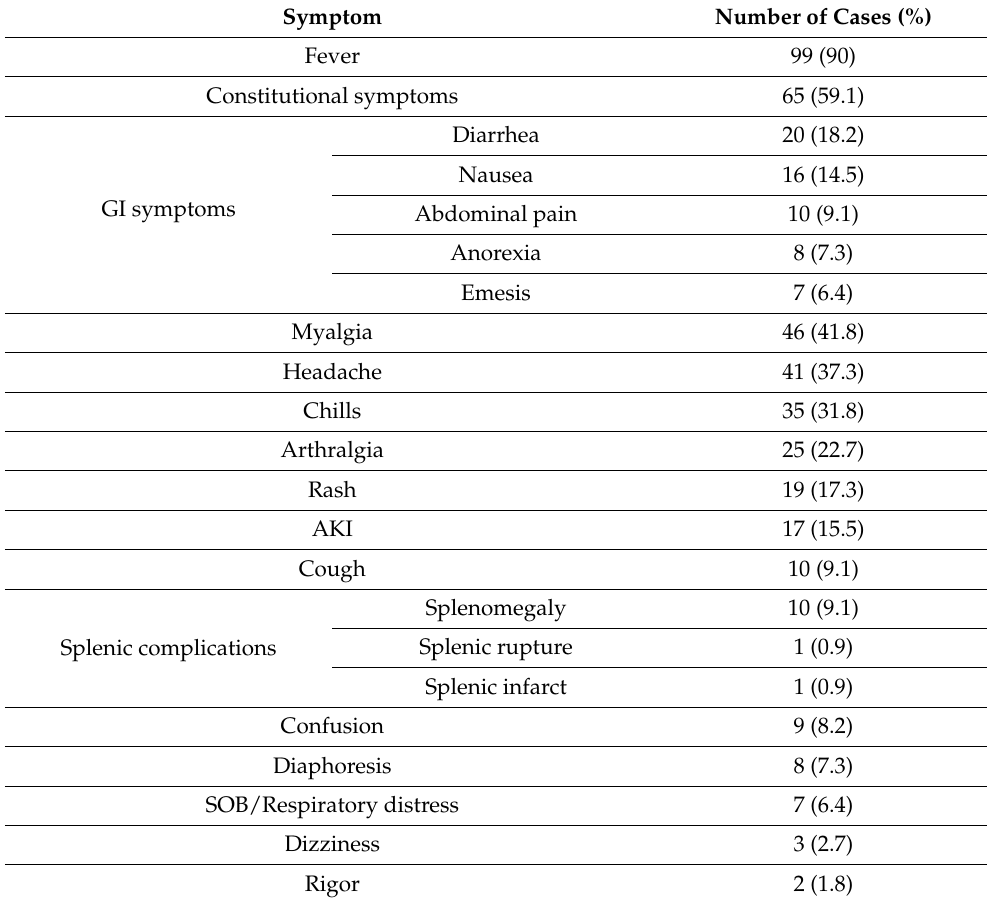
Table 2. Clinical manifestations of the patients diagnosed with